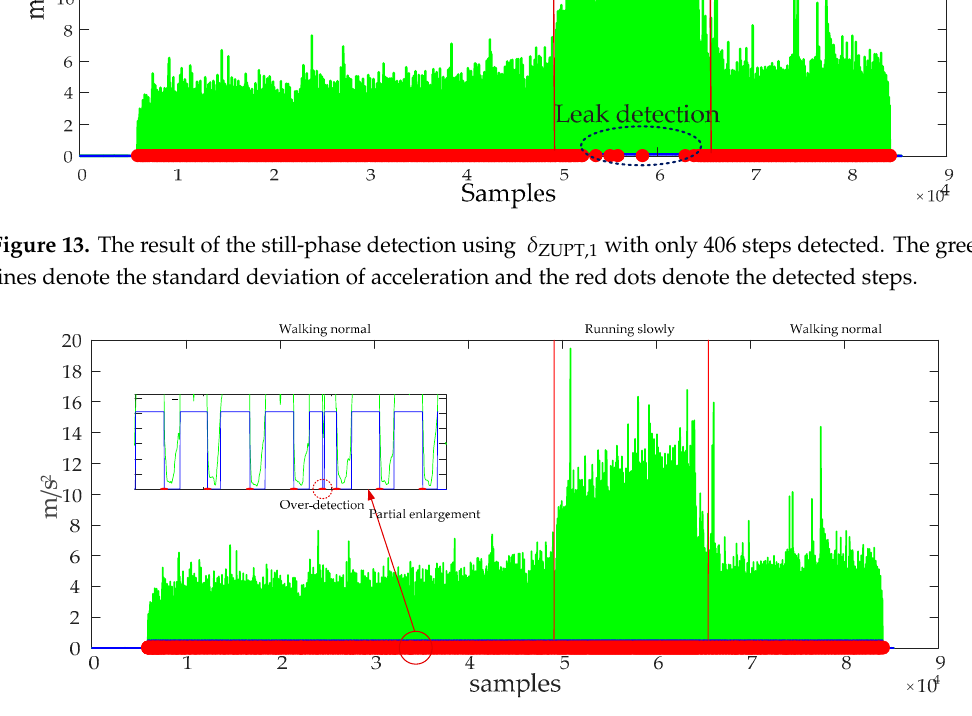
Figure 14. The result of the still-phase detection using δ ZUPT,2 with 598 steps detected. The green lines denote the standard deviation of acceleration and the red dots denote the detected steps.